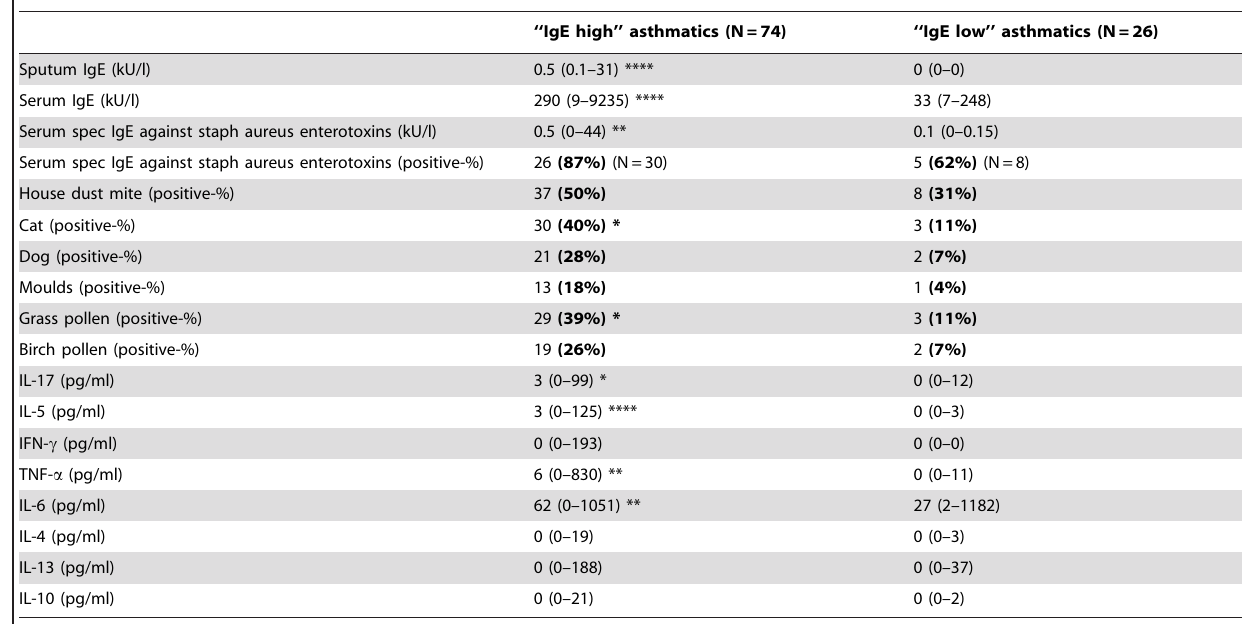
Table 4. Total sputum and serum IgE and sputum cytokine levels in ‘‘IgE high’’ vs ‘‘IgE low’’ asthmatics.